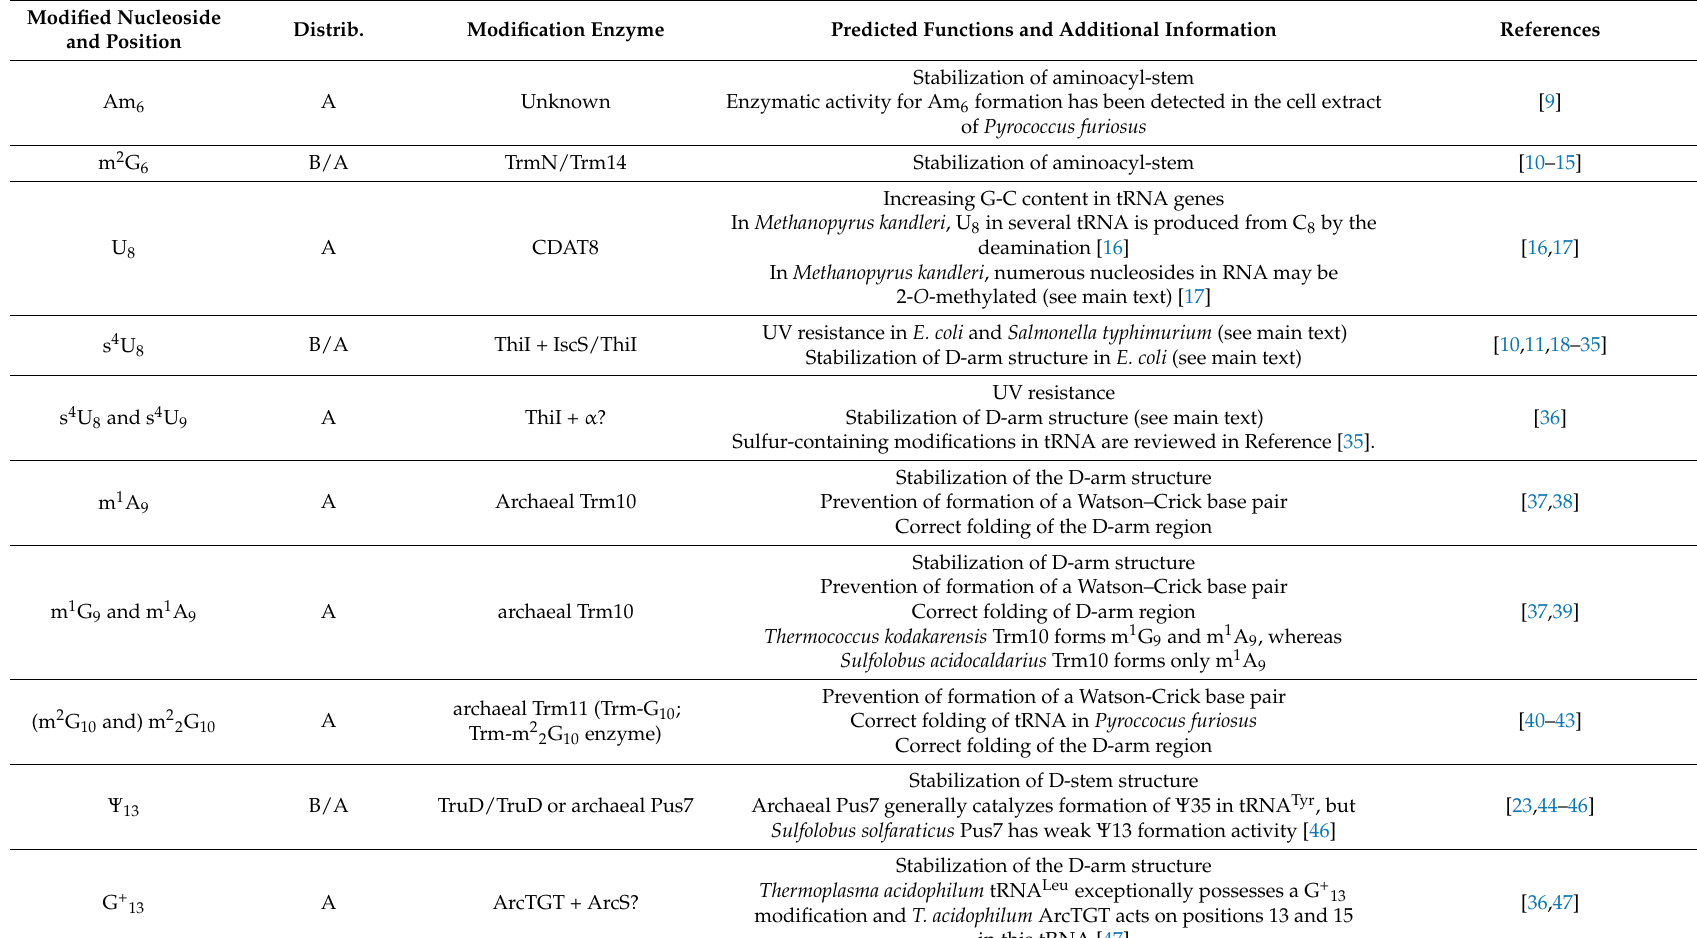
Table 1. Modified nucleosides in tRNA from